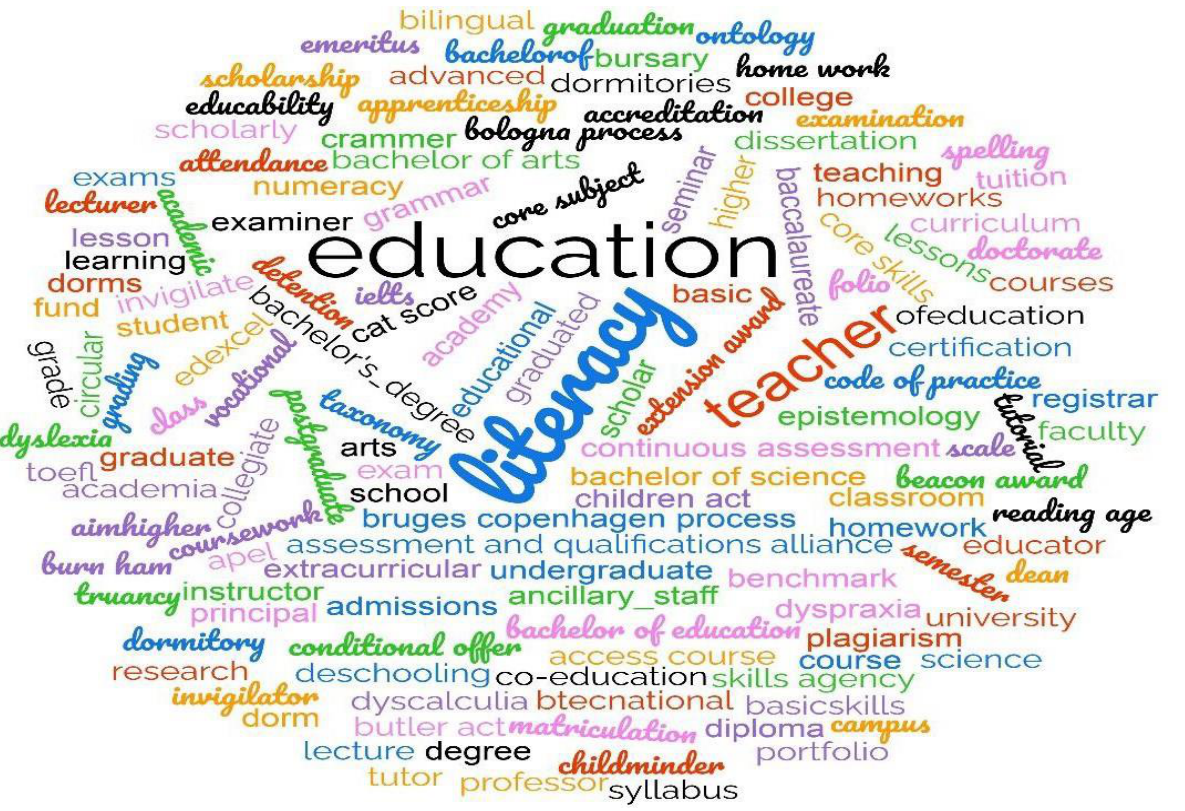
Figure 3. The vocabulary of the proposed education dictionary.